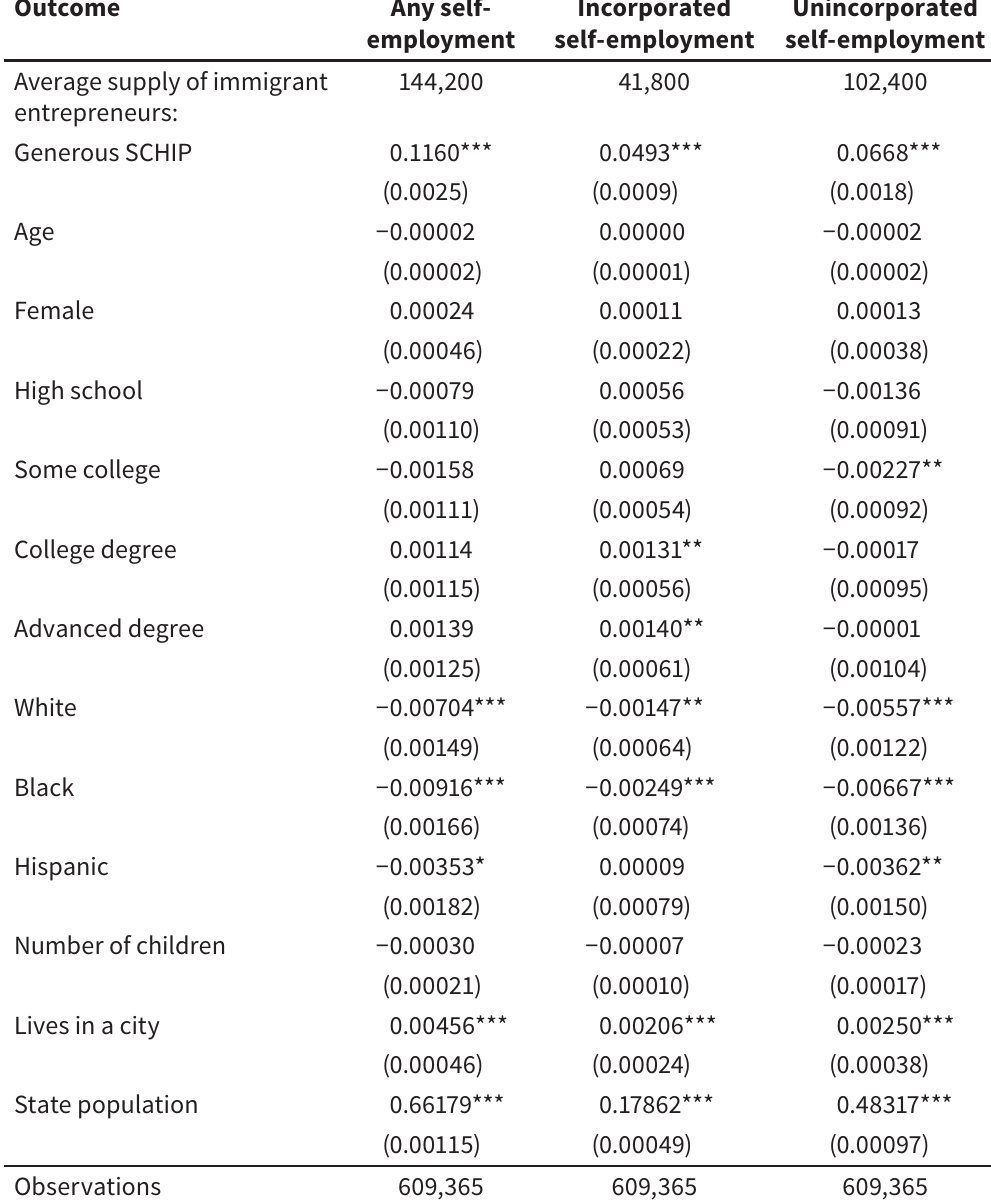
First-stage Regressions: Association between Generous SCHIP and Supply